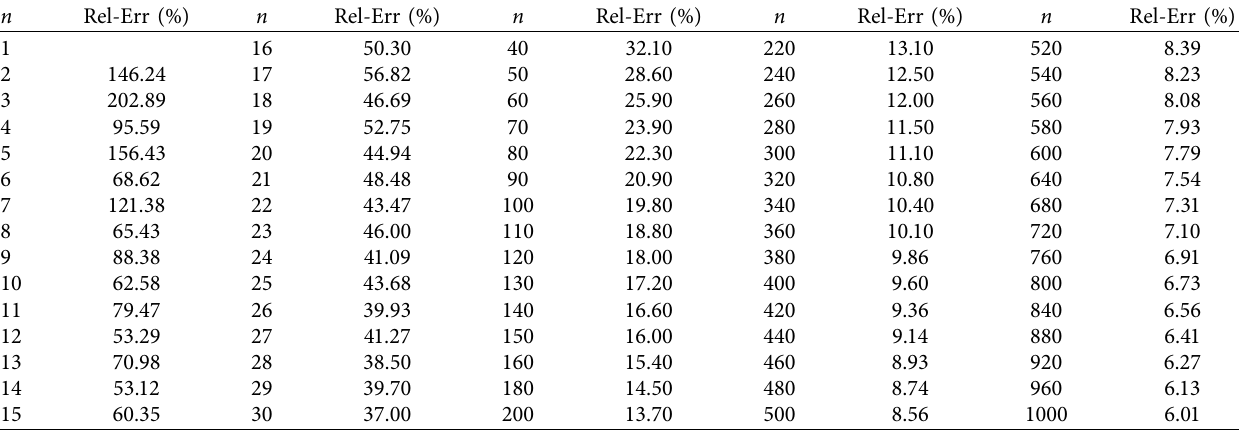
( n ) to h ( n ) when n ≤ 1000. g